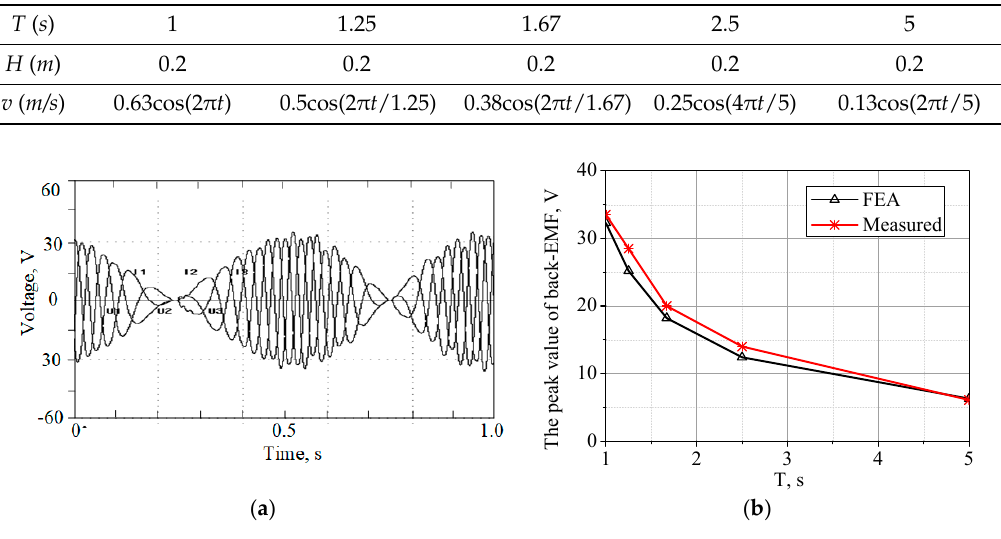
Figure 15. The experiment results of back-EMF for MI-TLPMG: ( a ) at the speed of 0.63cos(2 π t ); ( b ) different periods and speed listed in Table 2.